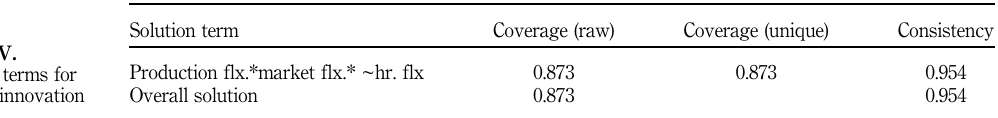
Table III. Truth table for the outcome “ ~product innovation ”